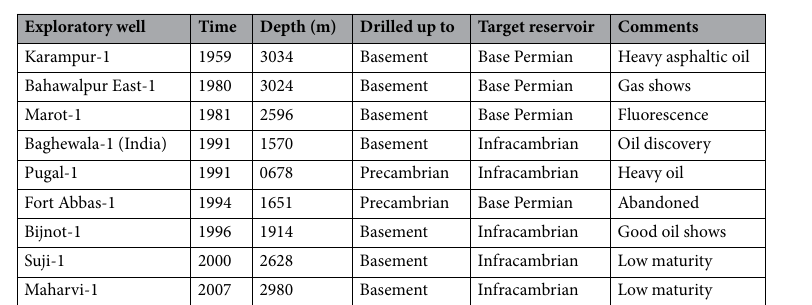
Table 2. Summary of the exploratory wells drilled through the Infracambrian to Permian play in SE Pakistan and Bikaner–Nagaur Basin India.